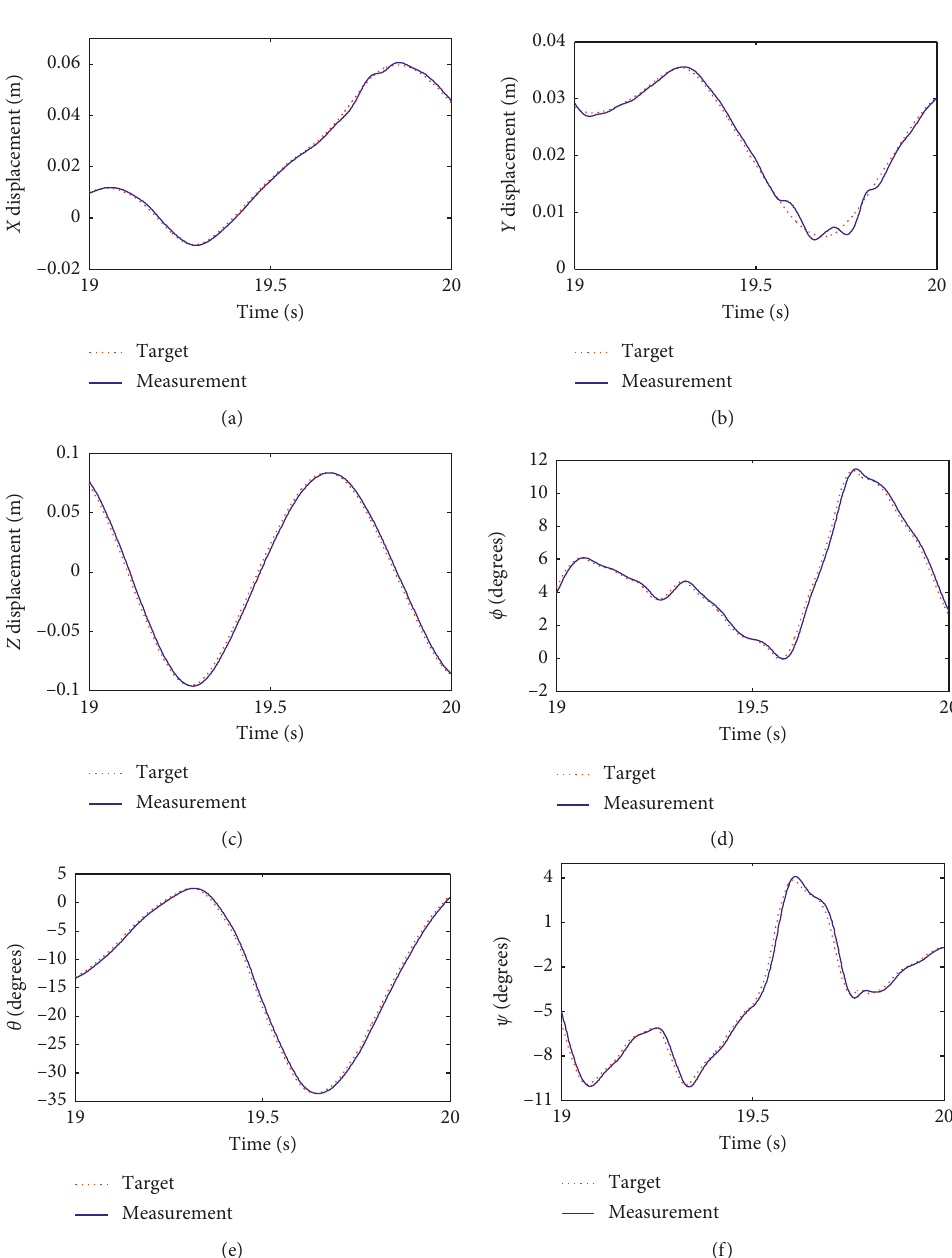
Figure 11: Attitude following curve of the vibration representation platform: (a) X displacement; (b) Y displacement; (c) Z displacement; (d) roll angle; (e) pitch angle; (f) yaw angle.